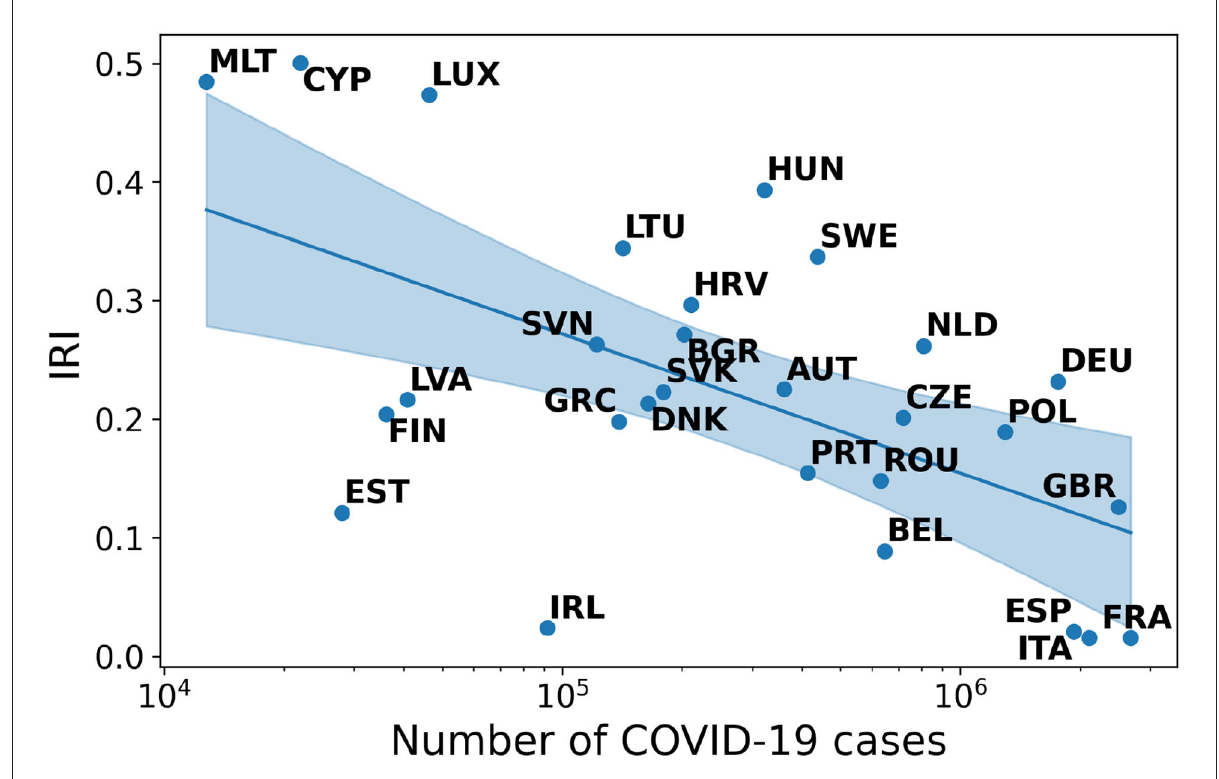
FIGURE3 Correlation between IRI and number of COVID-19 cases in